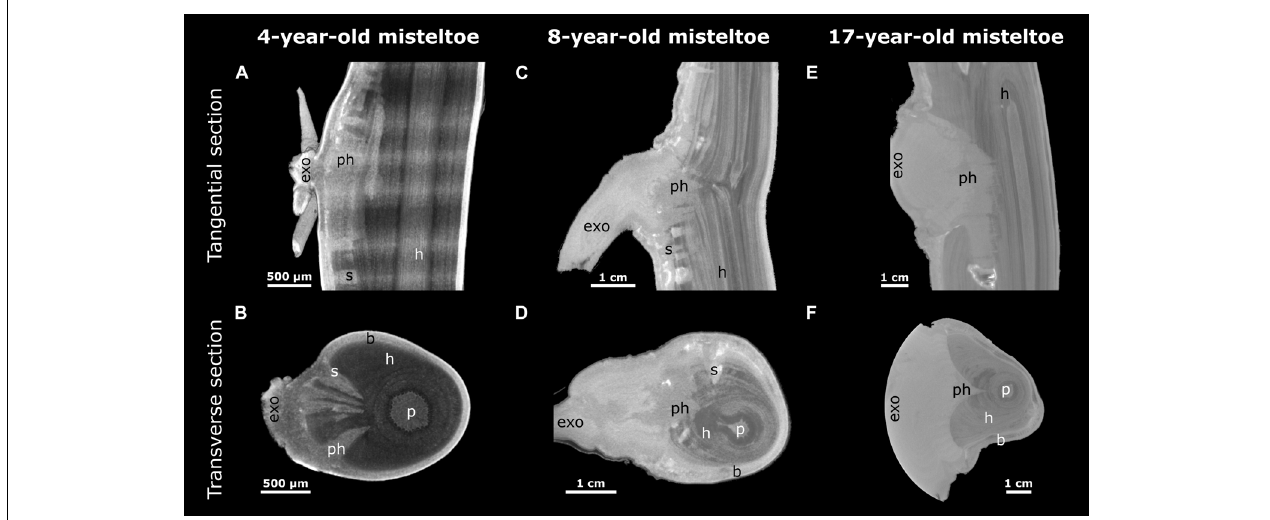
FIGURE 6 | Reconstructed X-ray microtomographic images of mistletoe-host interactions at various mistletoe ages. Tangential (A,C,E) and transverse sections ( B , D , F ; with regard to the host branch) through the attachment site are presented. The mistletoe, divided into exophyte (exo), primary haustorium (ph), sinker (s), and the host branch (h) with its pith (p) and bark (b) can be differentiated. A 4-year-old ( A , B , young), an 8-year-old ( C , D , middle age), and a 17-year-old ( E , F , old) mistletoe are presented as representatives of their age group. The semicircular geometry of the exophyte in panel (F) results from the circular restriction of the scan